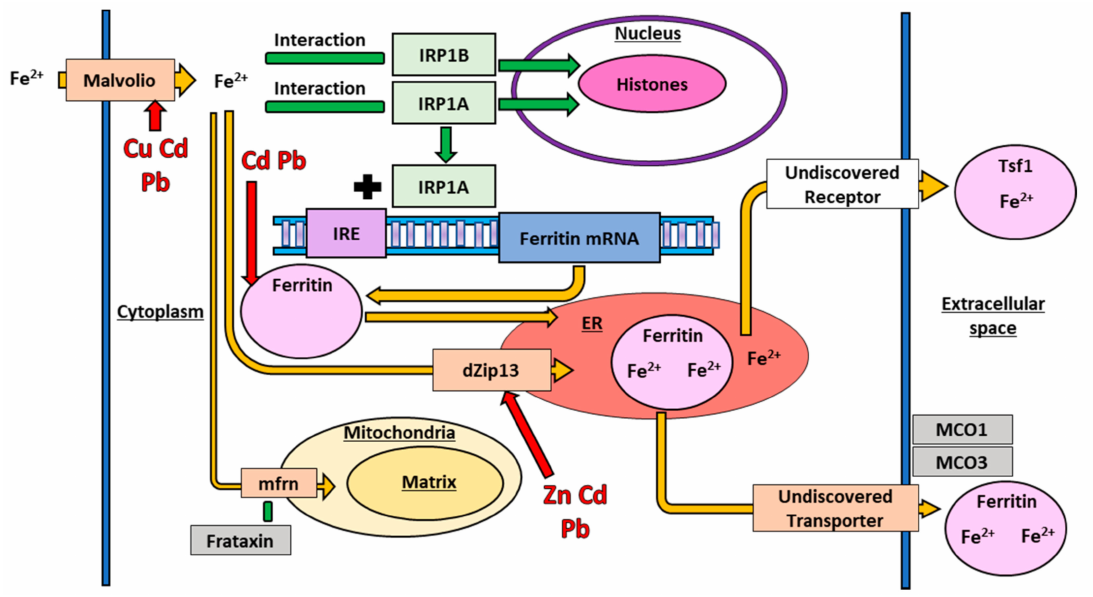
Figure 4. A diagram of the D. melanogaster Fe transport system transporting Fe and interactions with other metals. In addition to the pattern and colour scheme of all previous figures, histones are coloured magenta in our diagram, mRNA is coloured blue, and receptors are coloured white. Underlined labels denote areas inside the cell, organelles, or space outside of the